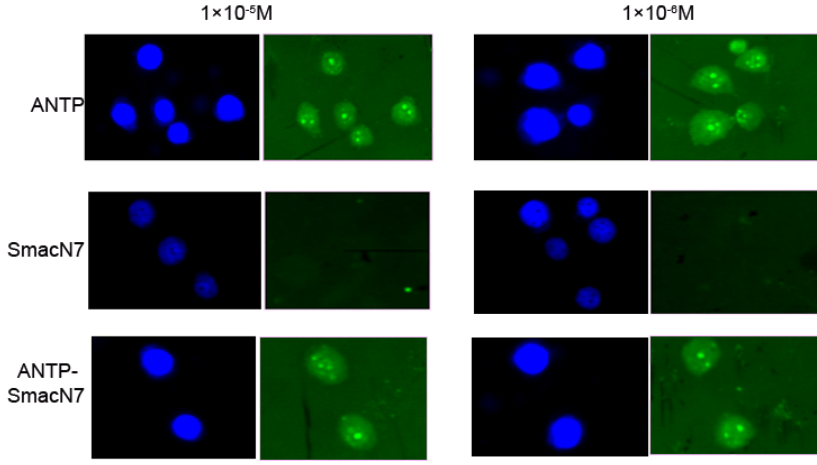
Figure 2. Comparison of cell transduction capabilities of SmacN7 and the ANTP-SmacN7 fusion protein. Blue shows nuclear staining (DAPI), green (FITC) shows carboxyl terminus-labelled ANTP, SmacN7 and ANTP-SmacN7.